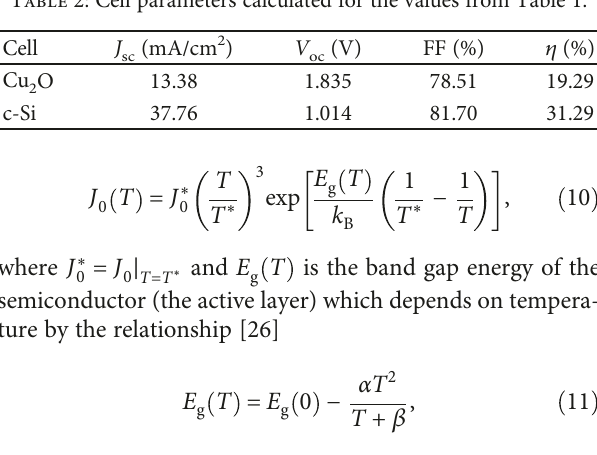
Table 2: Cell parameters calculated for the values from Table